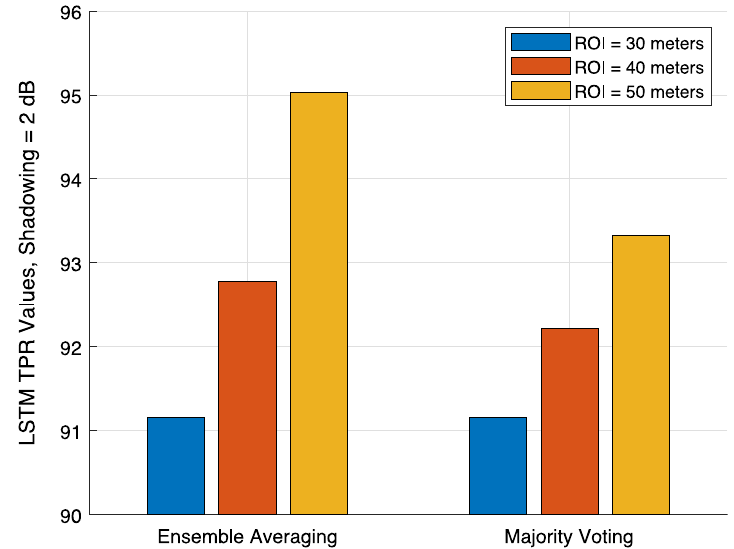
Fig. 10 TPRs of LSTM at 2 dB shadowing in two-state classification